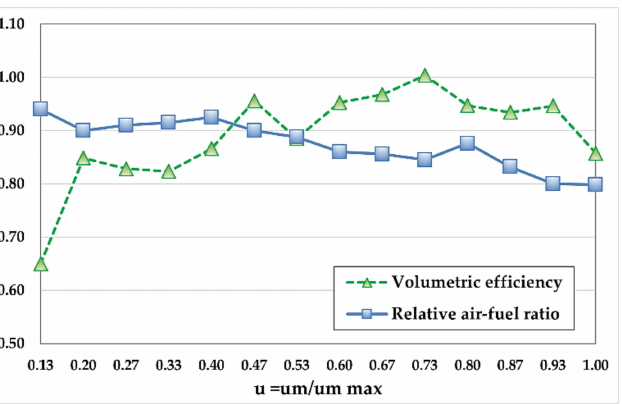
Figure 5. Volumetric efficiency and relative air–fuel ratio as functions of the normalized mean piston speed, at full load conditions.